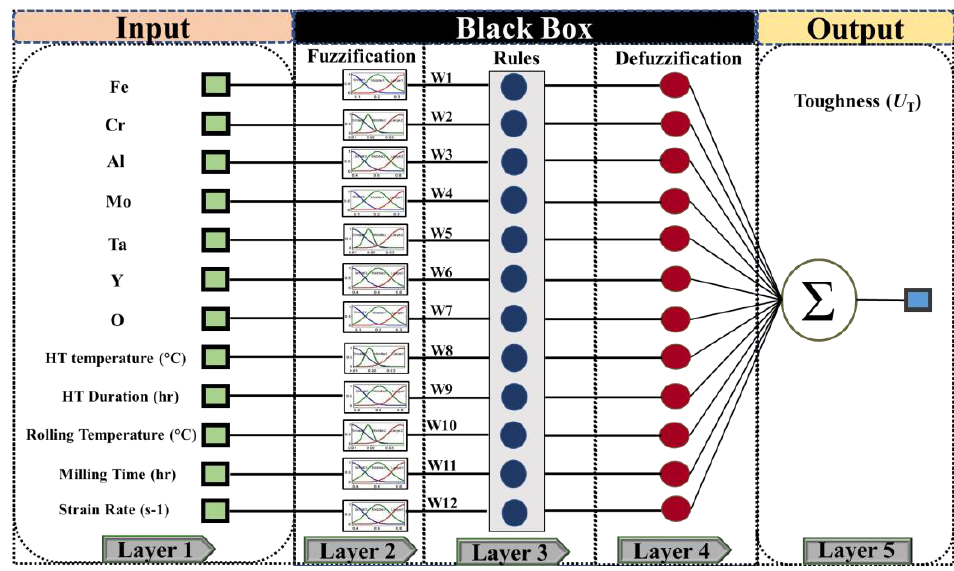
Figure 3. The structure of the ANFIS model for simulation of toughness consisting of 12 inputs and 5 layers [32].